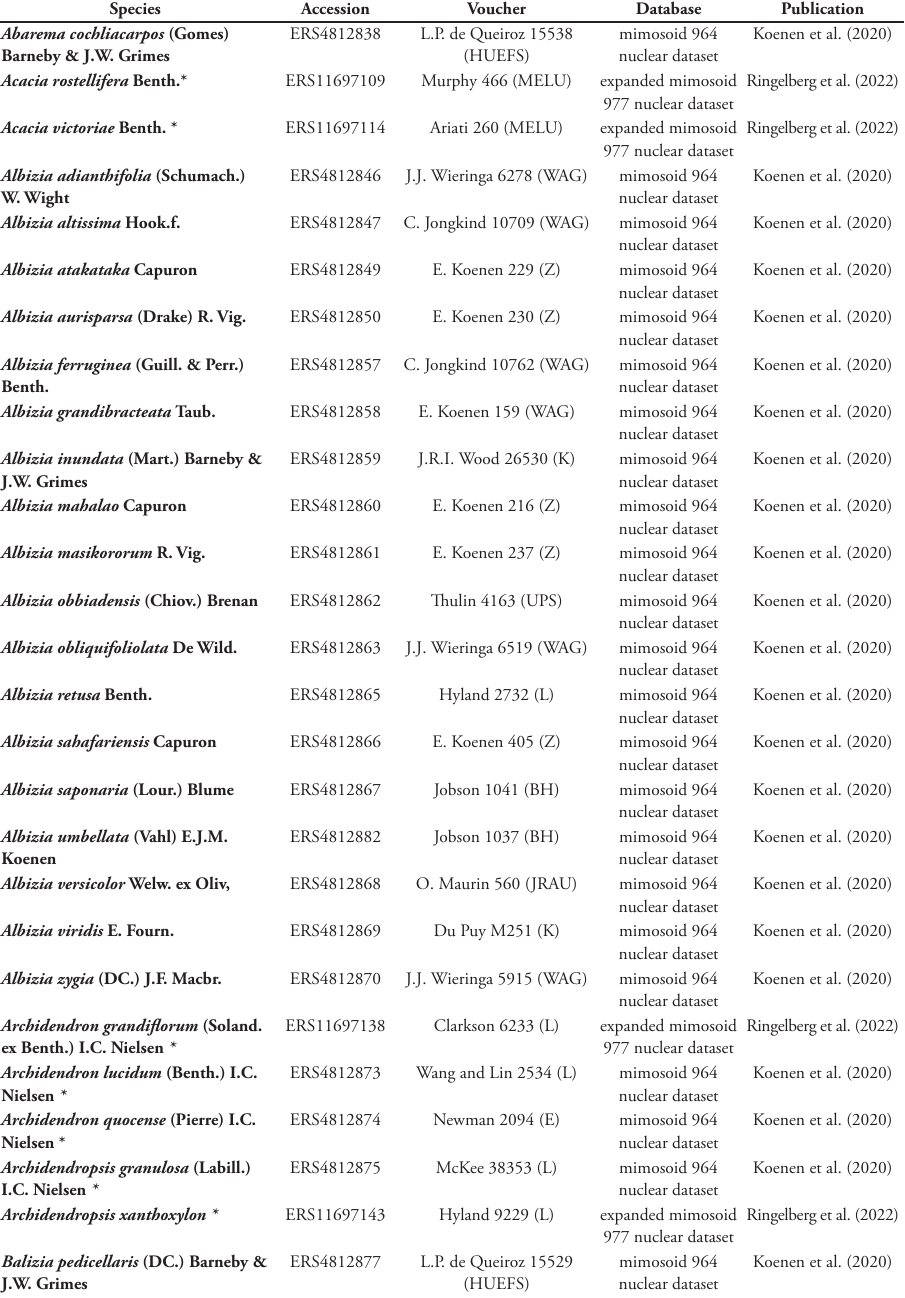
Table 2. Sample information for the taxa included in the ingoid clade phylogeny. This table includes sam- pling code/accession and voucher information for 57 taxa with the herbarium acronym shown in parenthe- ses, dataset name and publication. Taxa belonging to the Archidendron clade are indicated with an